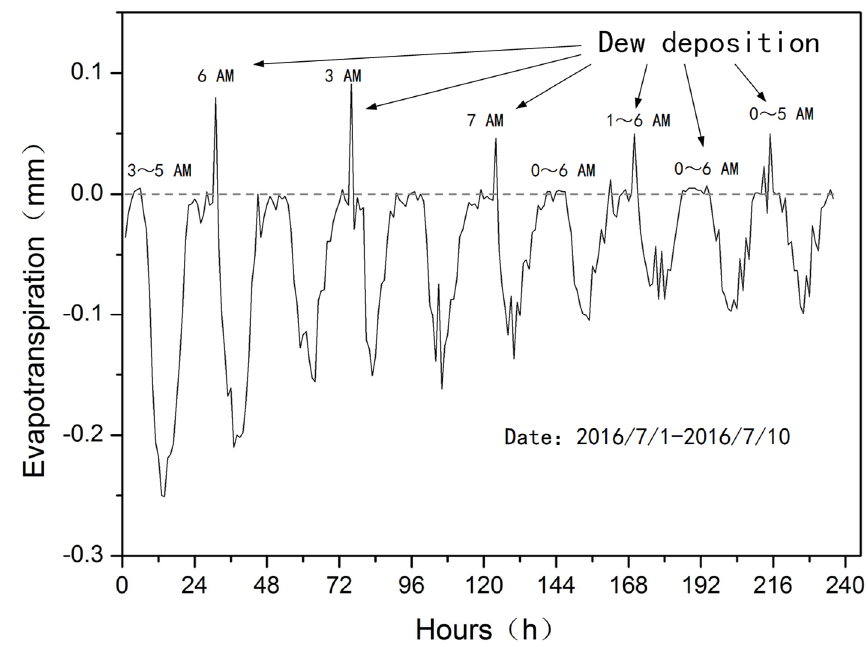
Figure 7. Dew deposition replenishment process between two precipitation events. The curves above the dashed line show the time when dew was deposited (usually in the early morning), and the fractions below show ET a during the precipitation interval of 1 July 2016–10 July